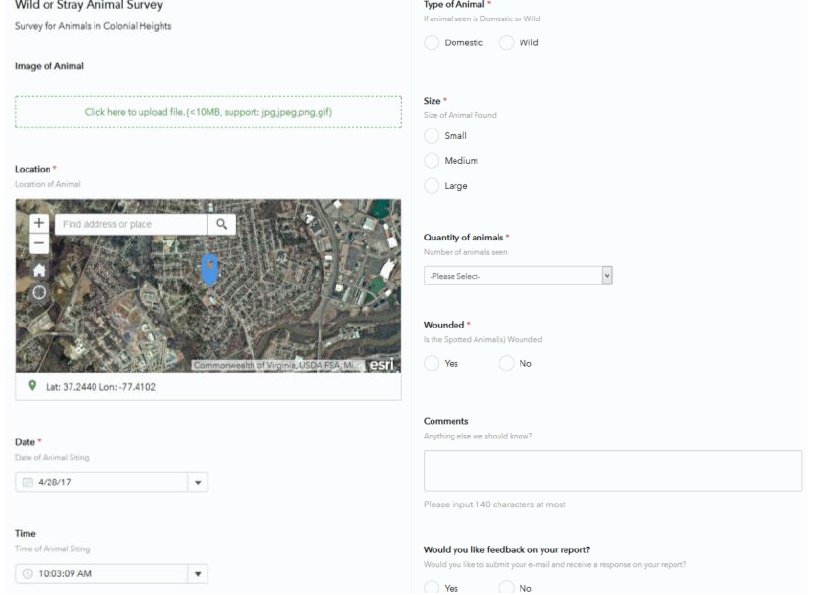
Figure 6 . Wild Animal Report Form (https://goo.gl/2JhDZp).